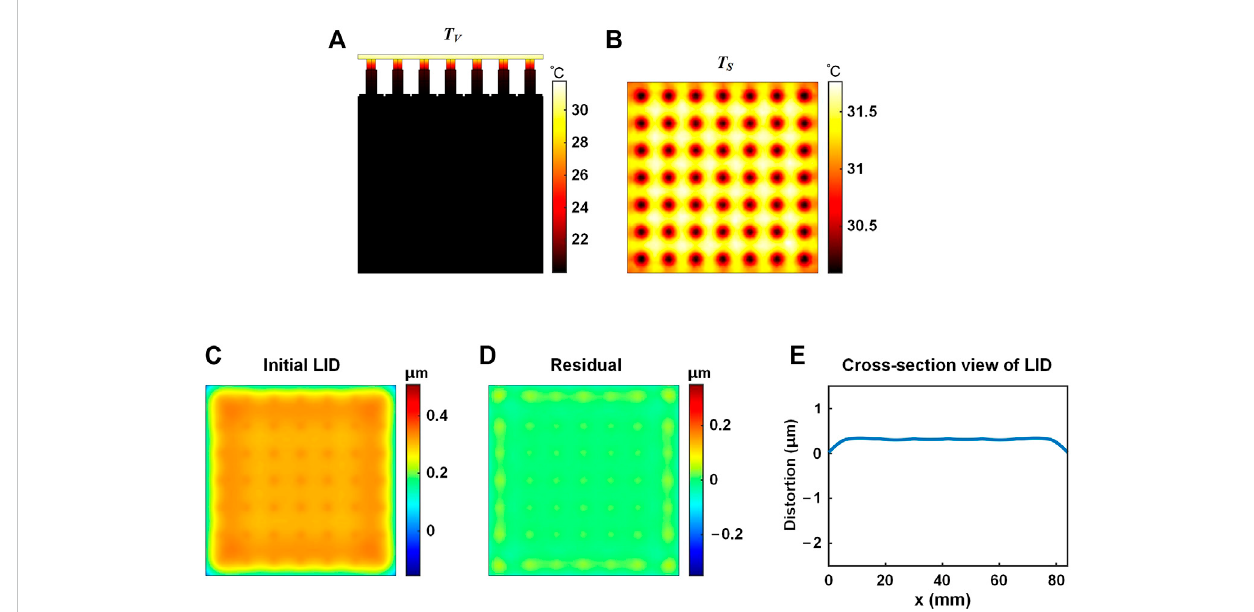
FIGURE 2 TemperaturedistributionandLIDoftheDDMunder60 slaserirradiation. (A) Overalltemperaturedistribution T V . (B) Mirrortemperaturedistribution T S . (C) Initial LID. (D) Self-correction residual. (E) Diagonal cross-section view of the LID.